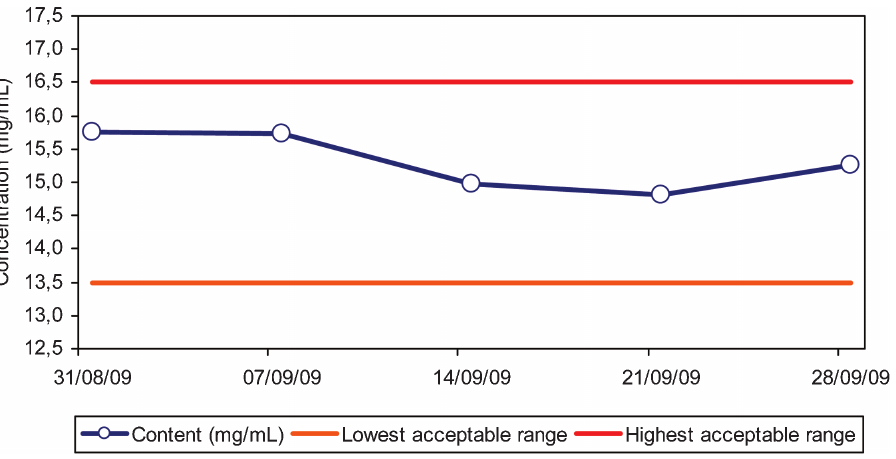
Figure 3 - Estimation of the product